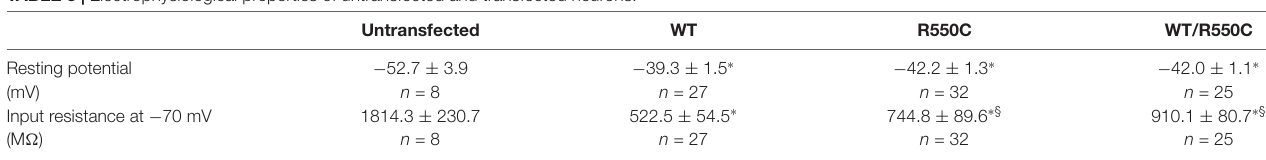
TABLE 3 | Electrophysiological properties of untransfected and transfected